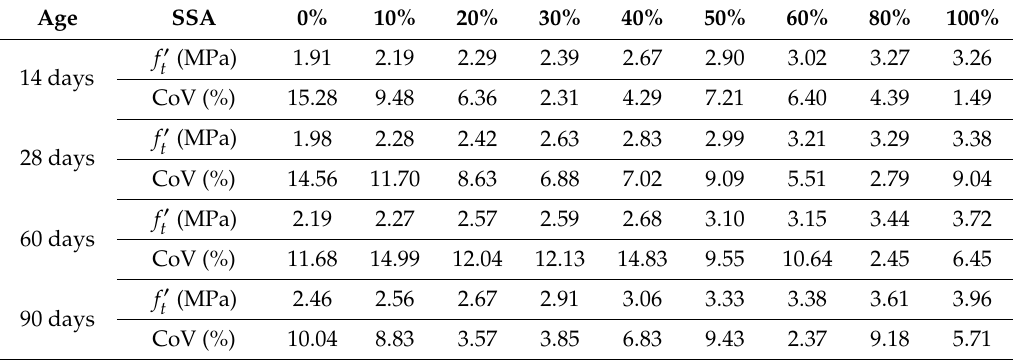
Figure 9. Tensile (splitting) strength: 𝑓 𝑡 ′ ( a ) and an increase in 𝑓 𝑡 ′ as a function of SSA ( b ), and normalized 𝑓 𝑡′ of concrete mixes measured at 28 days compared with other results found in the literature ( c ). Table 8. The average tensile strength ( f (cid:48) ) and coe ffi cient of variation (CoV) of t